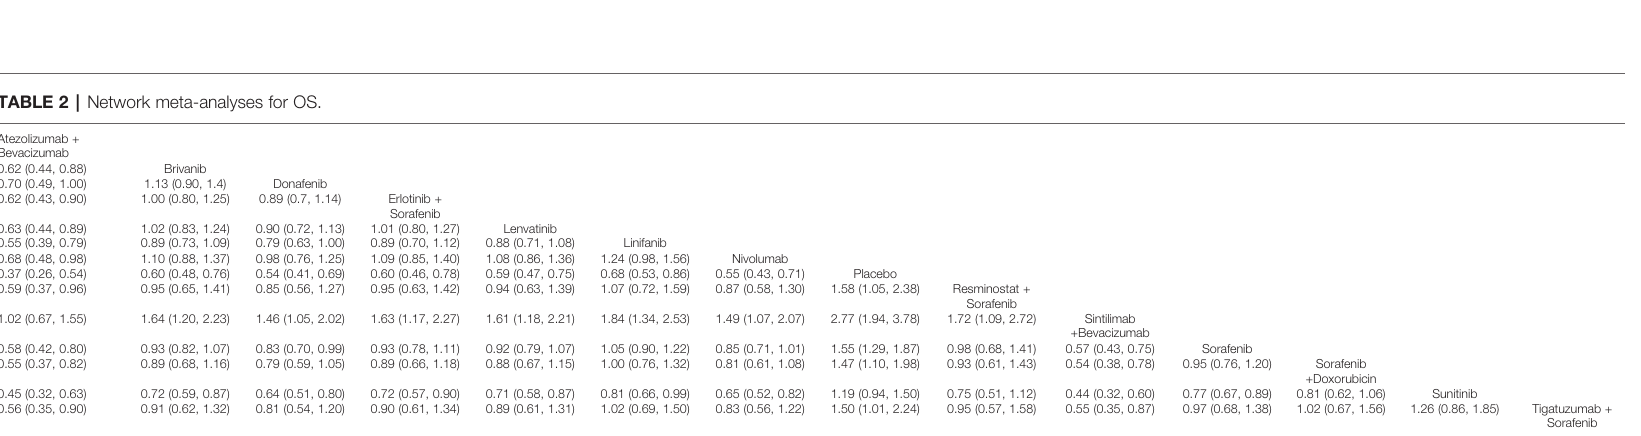
TABLE 2 | Network meta-analyses for